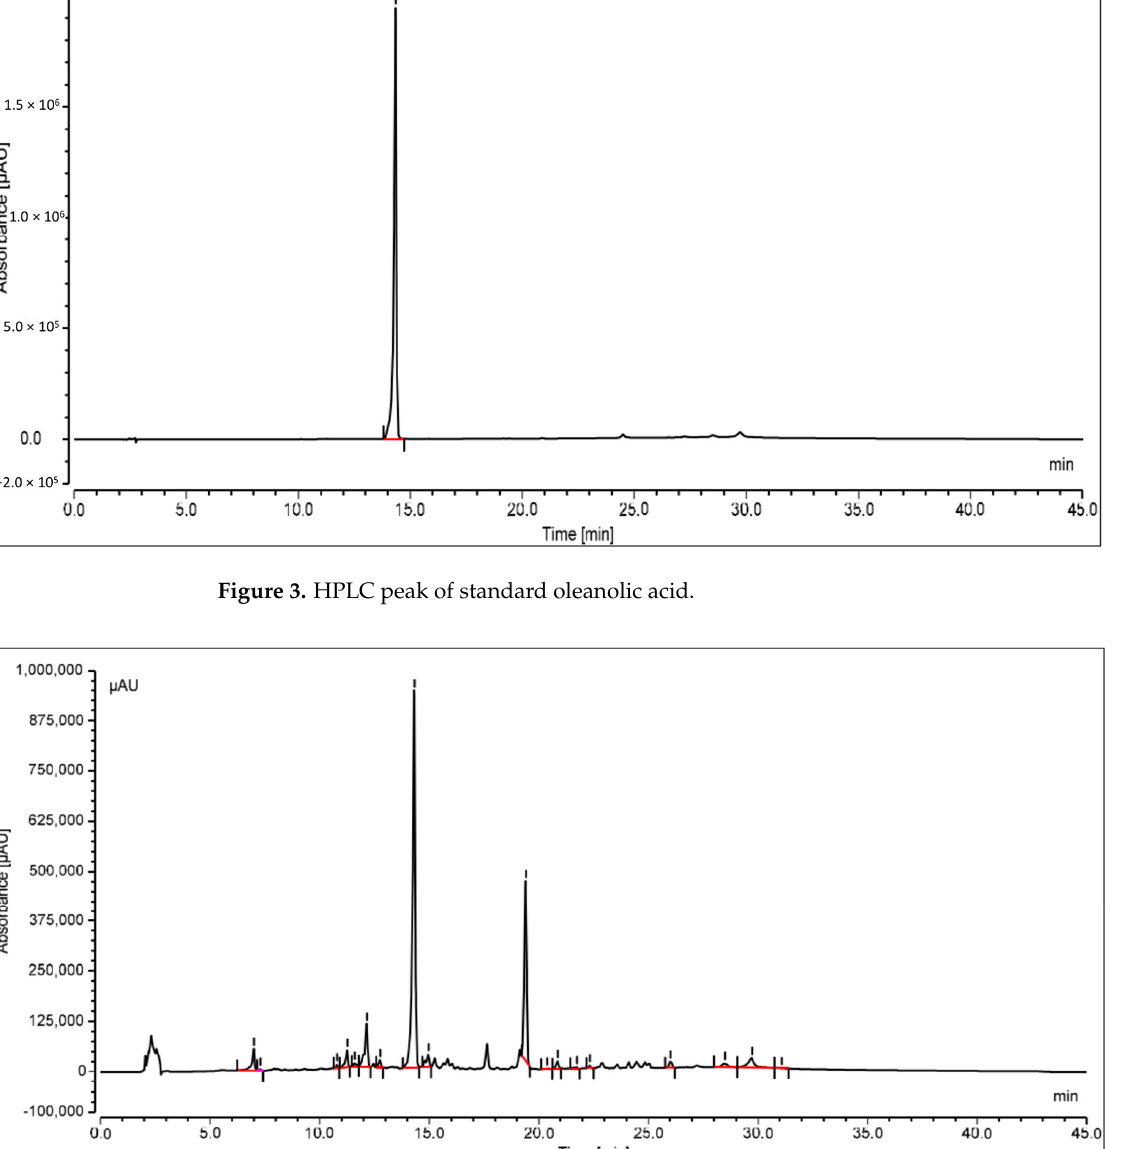
Figure 5. Effect of SMFE activity on 11 β -HSD1 dehydrogenase activity ( n = 3), p < 0.05. 3.4. Effect of SMFE Extract in STZ-Induced Diabetic Mice In contrast to normal controls, STZ-induced diabetic mice exhibited significantly higher blood glucose levels ( p < 0.01). Compared to the diabetic control group, the 200 mg/kg body weight and 400 mg/kg body weight doses of the SMFE extract caused signif- icant ( p < 0.05 and p < 0.01) reductions in blood glucose at 21 and 28 days, respectively. Additionally, when glibenclamide was given to group III at a 5 mg/kg dose, blood glucose levels dropped significantly ( p < 0.01) on days 14, 21, and 28. Groups IV and V received SMF extract at doses of 200 and 400 mg/kg body weight, respectively, and showed a